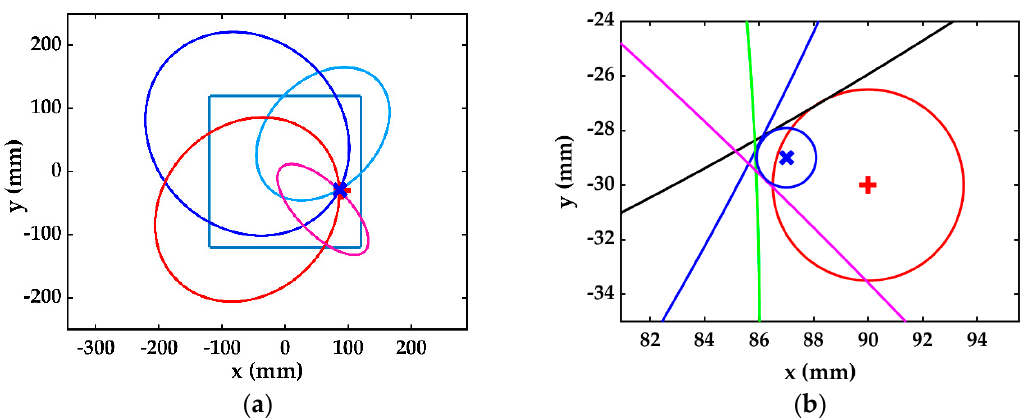
Figure 9. ( a ) Damage estimation in single-stage detection method. ( b ) Estimated (blue) and actual (red) damage.